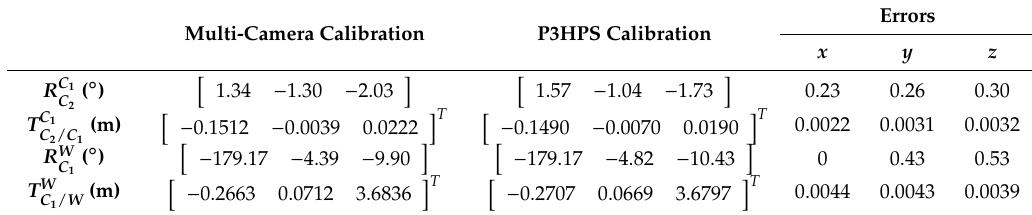
Table 5. Calibration comparisons between the proposed method and Phantom 3D high-speed photogrammetry system (P3HPS).